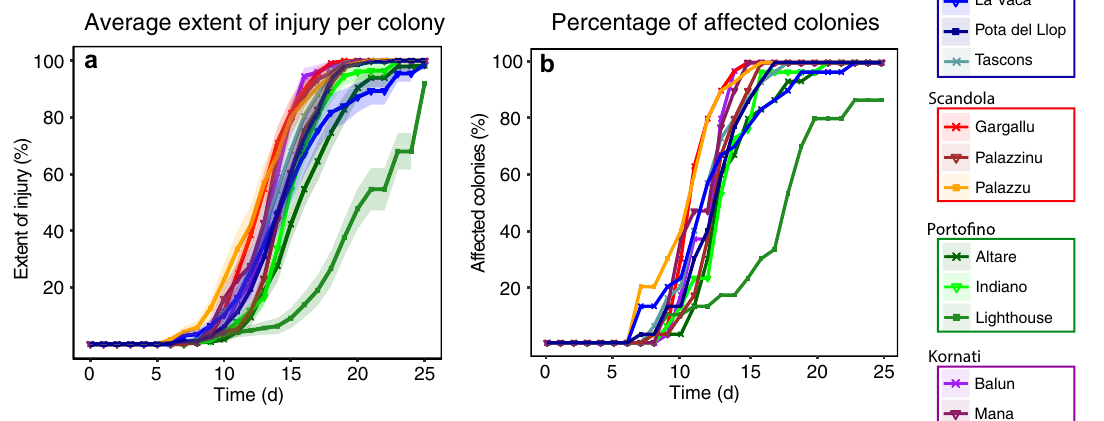
Figure 3. Extent of injury ± SE ( a ) and percentage of affected colonies ( b ) during the 25 days of exposure to thermal stress. Colors (i.e., blue, red, green and purple) correspond to the four localities while the different lines correspond to the 11 P. clavata populations analyzed.